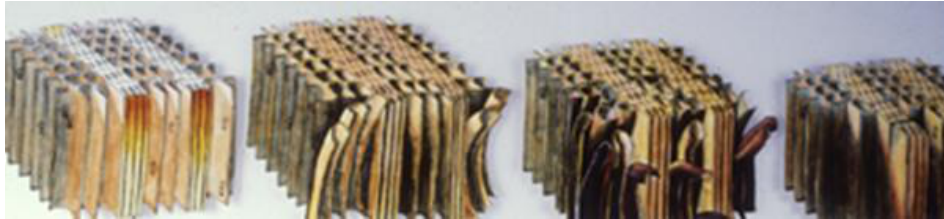
Figure 7. Loss of surface fibers due to UV degradation of lignin.